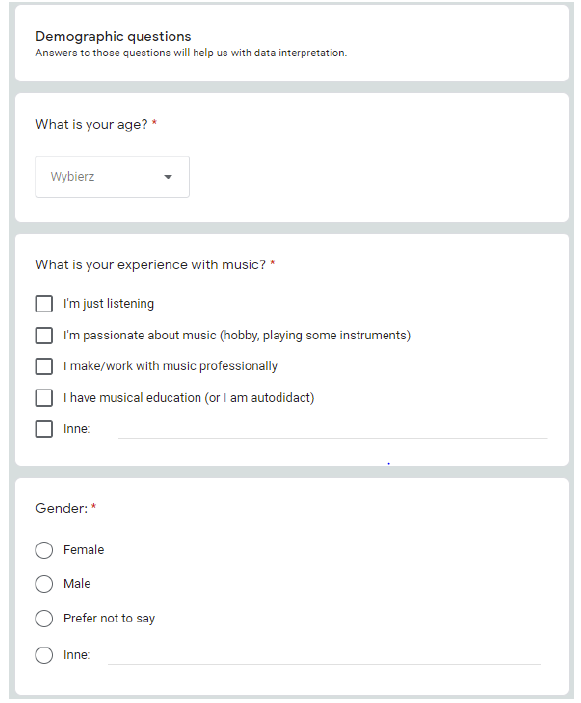
Figure 5. Demographic questions contained in the constructed online survey.